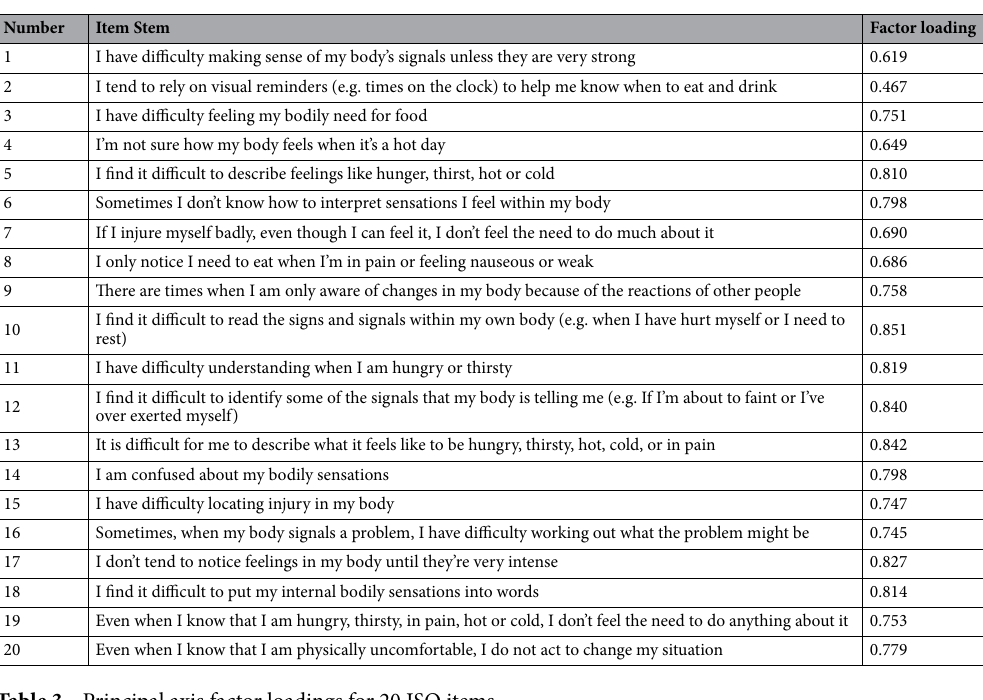
MAIA Emotional awareness